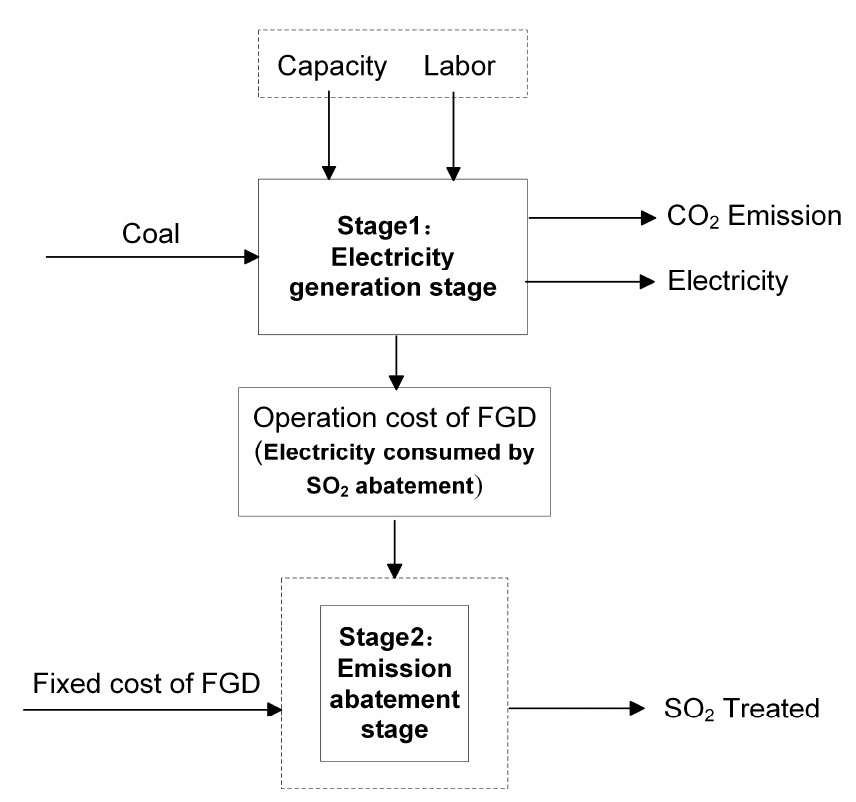
Figure 4. The production and abatement system of the coal-fired power plant.